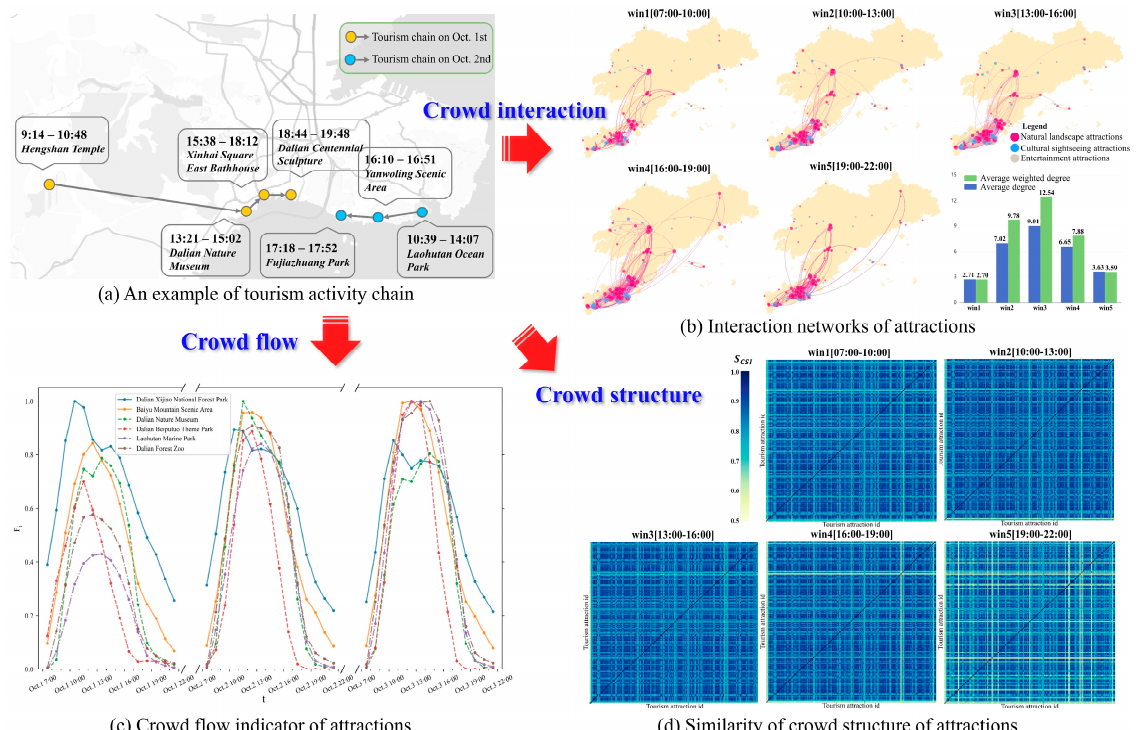
Figure 5. Distribution of major tourism attractions in Dalian.